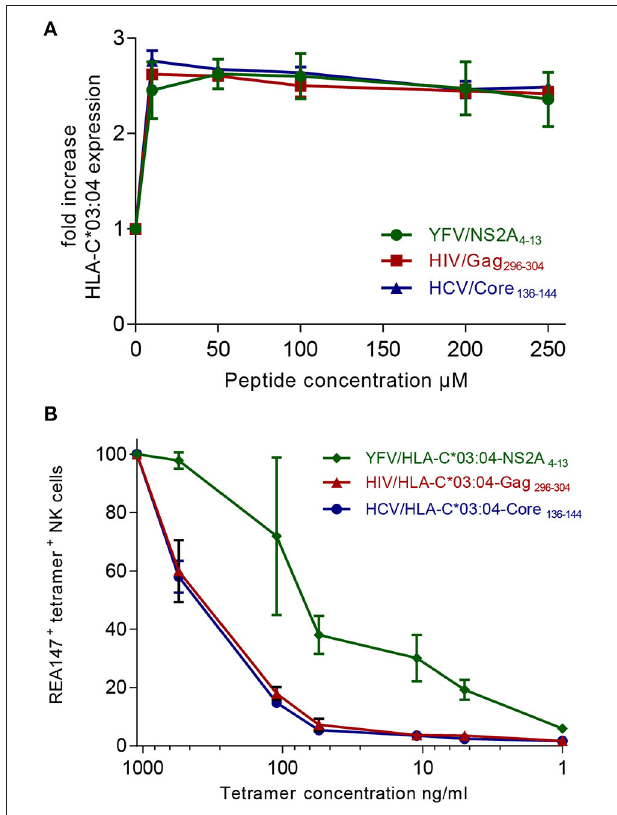
FIGURE 3 | The YFV/HLA-C*03:04-NS2A 4 − 13 -tetramer exhibits the strongest binding affinity to KIR2DL2/3. (A) Fold increase of HLA-C*03:04 expression on 221-TAPko-HLA-C*03:04 cells incubated with the indicated concentrations of the YFV/NSA2A 4 − 13 (green), the HIV/Gag 296 − 303 (red), and HCV/Core 136 − 144 (blue) peptides is shown. (B) Percentage of tetramer + KIR2DL2/3 + (clone REA147 + ) NK cells stained with YFV/HLA-C*03:04-NS2A 4 − 13 -, HIV/HLA-C*03:04-Gag 296 − 304 - and HCV/HLA-C*03:04-Core 136 − 144 -tetramers are shown at the indicated tetramer